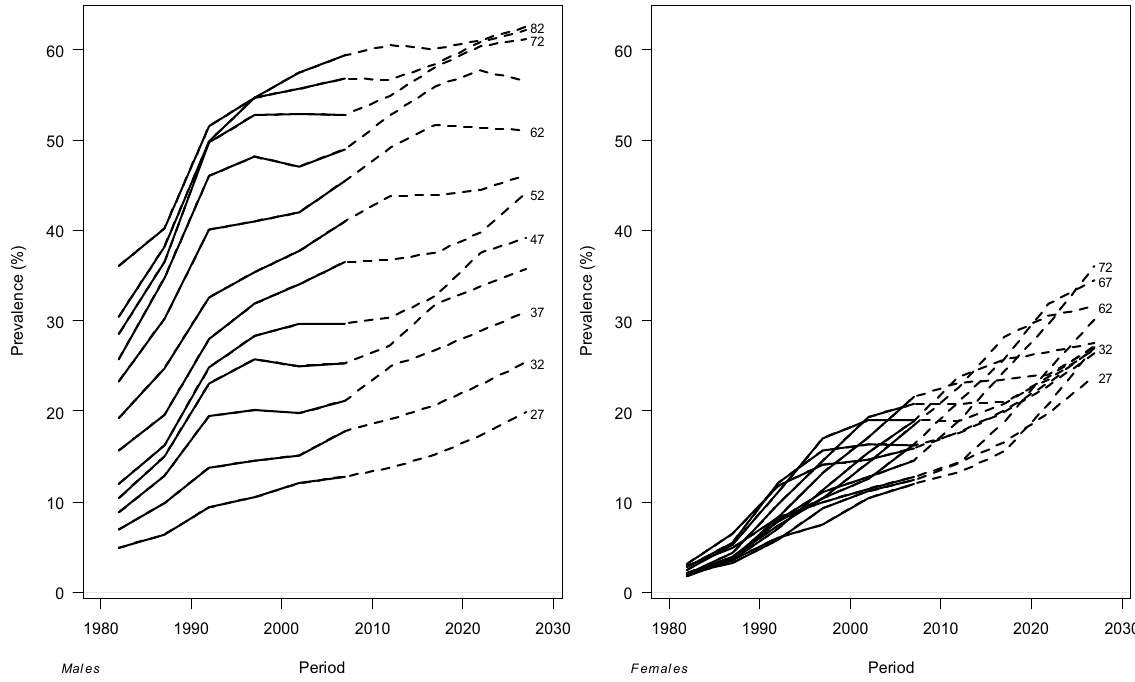
women. As in the age-specific estimates, also in this case projections for the last period were highly uncertain with credible intervals rapidly widening (Figure 4). Figure 3. Age-specific prevalence of former smokers by period, fitted in 1980–2009 (solid line) and projected for 2010–2030 (dotted line) for males and females.